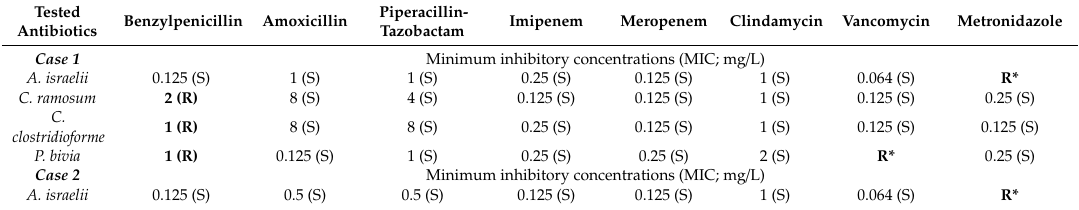
Table 1. Antimicrobial susceptibility testing results for strict anaerobes in Cases 1 and 2. Tested